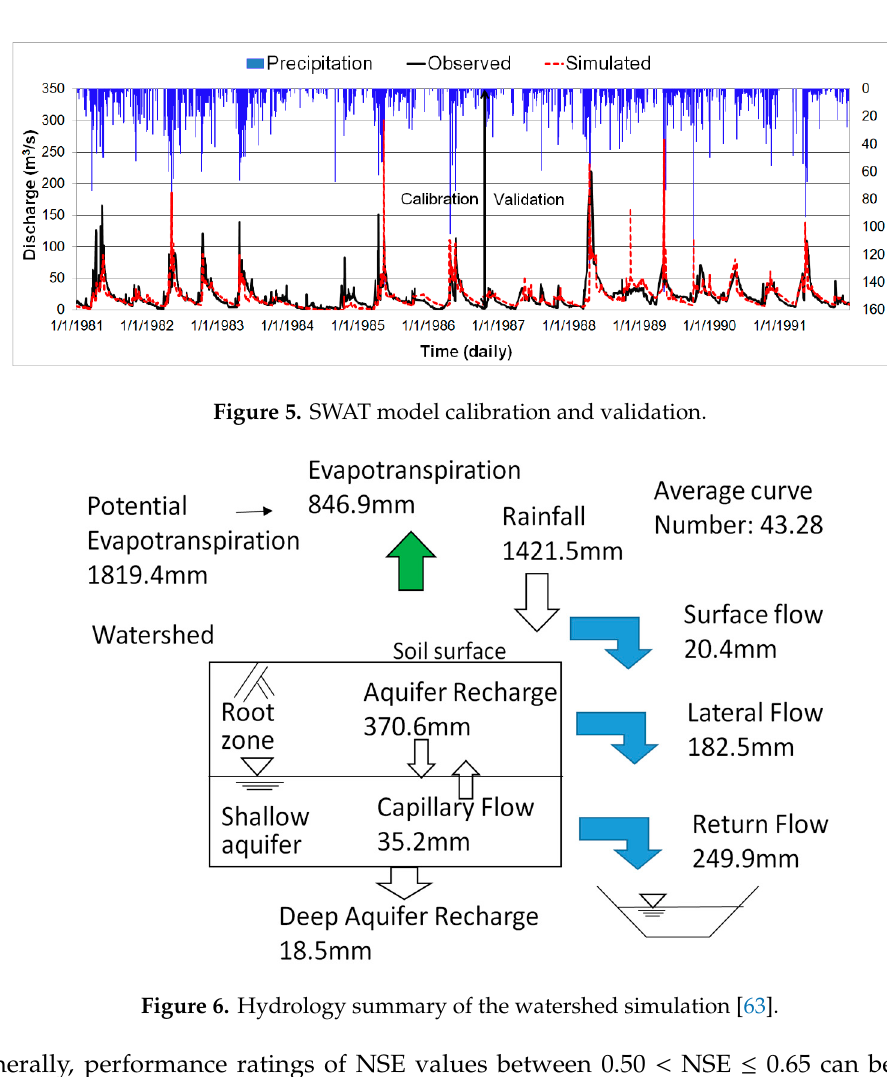
Figure 7. Comparison of total available flow (historical simulation) with water demand (2013–2016). 3.4. Climate Change Modeling SWAT was run again (after the calibration and validation) using the downloaded, downscaled and bias-corrected future climate data from the three GCMs (four RCPs each) to analyze future total available flow at the two weir intakes on the River Thiba and the River Nyamindi. The future irrigation water requirement was also estimated using the future climate data from the three GCMs (four RCPs each). Figures 8–11 show the future water total available flow and irrigation water requirement comparisons under RCPs 2.6, 4.5, 6.0 and 8.5, respectively for two time periods, i.e., 2020–2060 and 2061–2099.